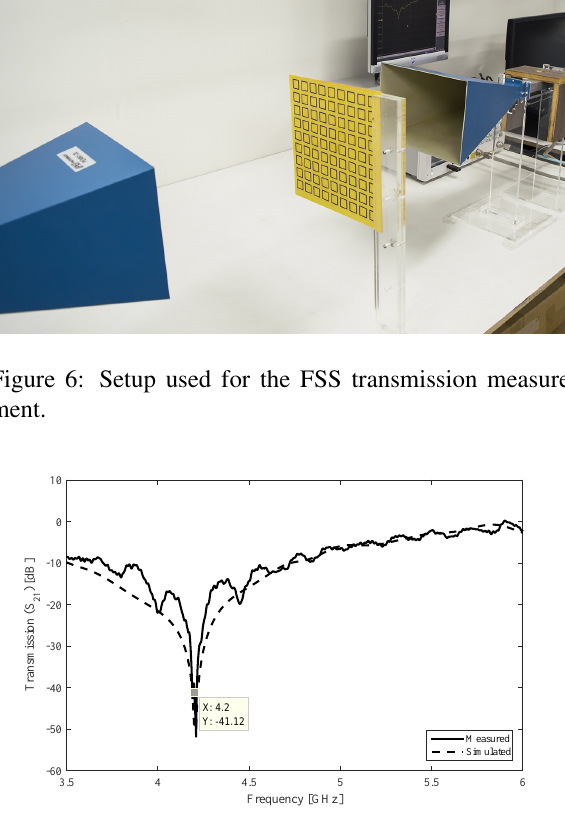
ulated and measured experiment with the FSS as a reflective